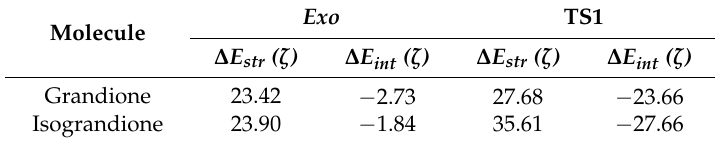
Table 3. Deformation and interaction energy (kcal/mol) at the TS in grandione and